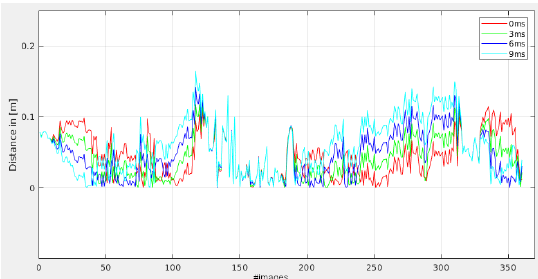
Figure 11. Distances between GNSS positions (mode A) and aerial image positions for four different latency times at the calibration track.